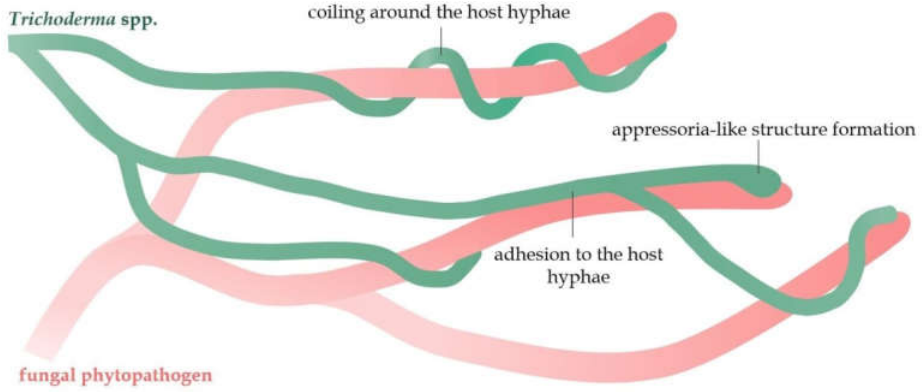
Figure 2. Biocontrol mechanisms used by the Trichoderma genus against fungal pathogens.